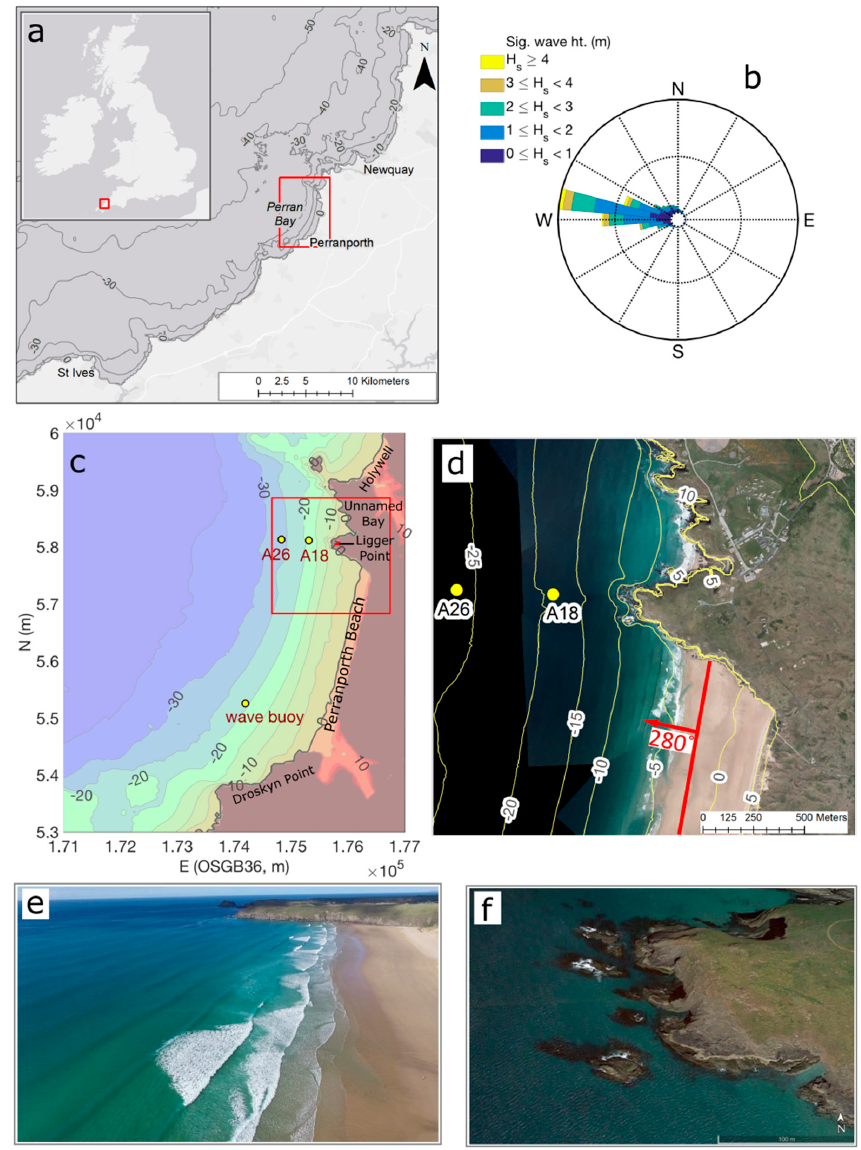
Figure 1. Study site: ( a ) regional map of a section of North Cornwall; ( b ) wave rose for Perranporth using 10 years of wave buoy data; ( c ) Perranporth embayment, with instrument positions; ( d ) aerial photo of the headland of interest at spring low tide (United Kingdom Hydrographic Office (UKHO), 2011) with shore-normal orientation indicated (280°); ( e ) Ligger Point headland at the northern end of Perranporth Beach [photo: P. Ganderton]; and ( f ) oblique Google Earth image of Ligger Point. The projection and coordinate system are BNG/OSGB36. Contours in ( c , d ) are in Ordnance Datum Newlyn (ODN) coordinates and are based on 2016 surveys (note the aerial image in ( d ) is taken in 2011).